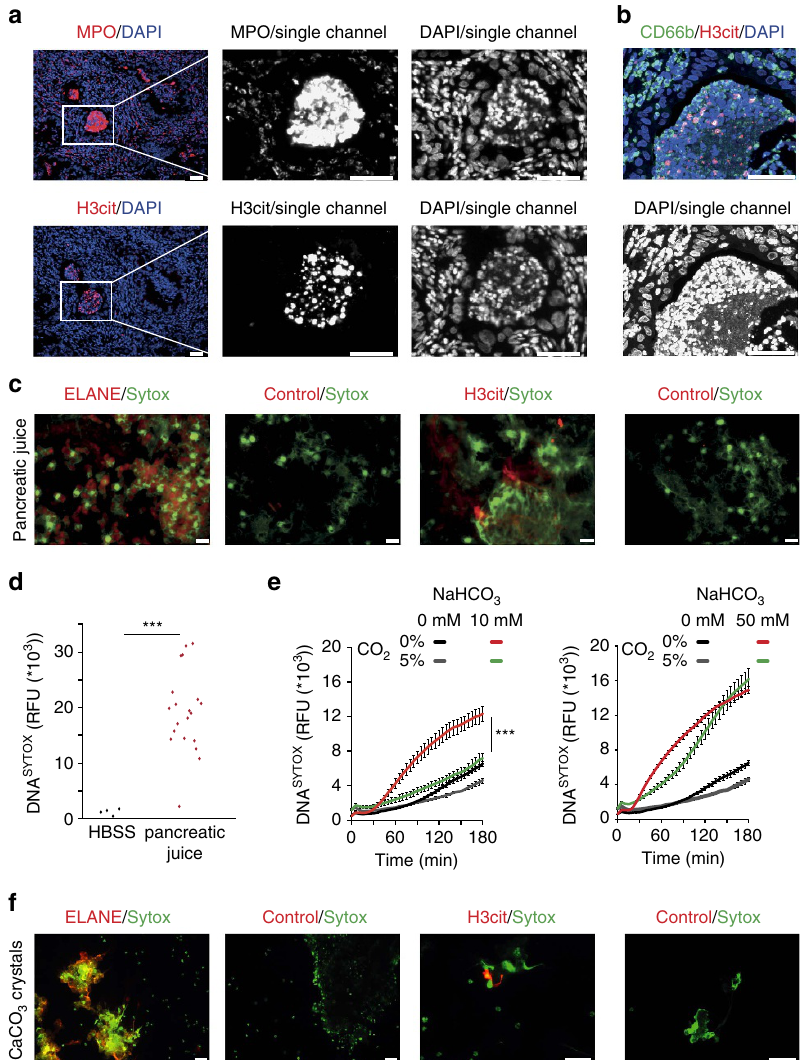
Figure 3 | Components of pancreatic juice facilitate externalization of decondensed neutrophil chromatin. ( a ) Immunofluorescence of myeloperoxidase (MPO) and citrullinated histone H3 (H3cit) revealed intraductal neutrophil aggregates in human pancreatic inflammation (immunopositivity rates of samples: malignancy-related pancreatitis (3/8) and benign chronic (0/5) pancreatitis, respectively); single channels are provided to appreciate low- intensity extracellular DNA between intact neutrophils. ( b ) Intraductal aggregates display CD66b þ cells and co-labelling of H3cit and extracellular DNA (3/3). ( c ) Cytospins from fresh patient-derived pancreatic fluid punctates of patients with benign pancreatitis revealed DNA webs positive for (left) neutrophil elastase (ELANE) and (right) H3cit with the respective staining control (right column; n ¼ 3/3). ( d , e ) Freshly isolated human blood neutrophils were cultured in human pancreatic juice or isotonic HBSS-based buffers containing varying amounts of NaHCO 3 , as indicated. DNA in the cell culture was quantified with a Sytox Green fluorimetric assay detecting extracellular DNA and chromatin of permeabilized cells only (DNA SYTOX ). ( d ) Quantitative assessment indicated strong increases in DNA SYTOX of human neutrophil cultures in response to human pancreatic juice ( n ¼ 20; 3h of stimulation). ( e ) NaHCO 3 dose dependently raises DNA SYTOX as compared with NaHCO 3 -free conditions. This effect was facilitated by ambient pCO 2 levels. Five percent of CO 2 was able to inhibit DNA detection induced by 10mM NaHCO 3 , yet failed to inhibit DNA detection at higher concentrations of NaHCO 3 (50mM; n ¼ 3 independent experiments, mean þ s.e.m.). ( f ) Freshly isolated human blood neutrophils grown on coverslips developed decondensed chromatin and aggregates positive for (left) neutrophil elastase and citrullinated histones (right) in response to calcium carbonate crystals (5mgml (cid:2) 1 , Z 4 independent experiments). (All white scale bars, 50 m m. * P o 0.05, ** P o 0.01, *** P o 0.001, Student’s t- decondensed chromatin to the extracellular space as demon- ionic composition of pancreatic juice. Pancreatic juice most strated by live-cell video microscopy (Supplementary Fig. 9A; strongly differs from serum with regard to its mildly alkaline Supplementary Movie 1). Sytox Green detects extracellular DNA pH and a bicarbonate concentration of up to 150 mM and DNA of permeabilized cells only (DNA SYTOX ). Quantitative (Supplementary Fig. 8; Supplementary Table 1). Bicarbonate is fluorimetric studies of neutrophils cultured in human pancreatic present in the juice of both healthy individuals and affected juice (chronic pancreatitis, pancreatic cancer) showed strong patients. Its concentration increases strongly after meals to increases in DNA SYTOX (Fig. 3d). We then studied which neutralize the gastric content in the small intestine 42 . We components of pancreatic juice contribute to increases in speculated that bicarbonate might contribute to aggNET DNA SYTOX in neutrophil cell cultures. We first examined the formation in pancreatic juice. Indeed, video microscopy